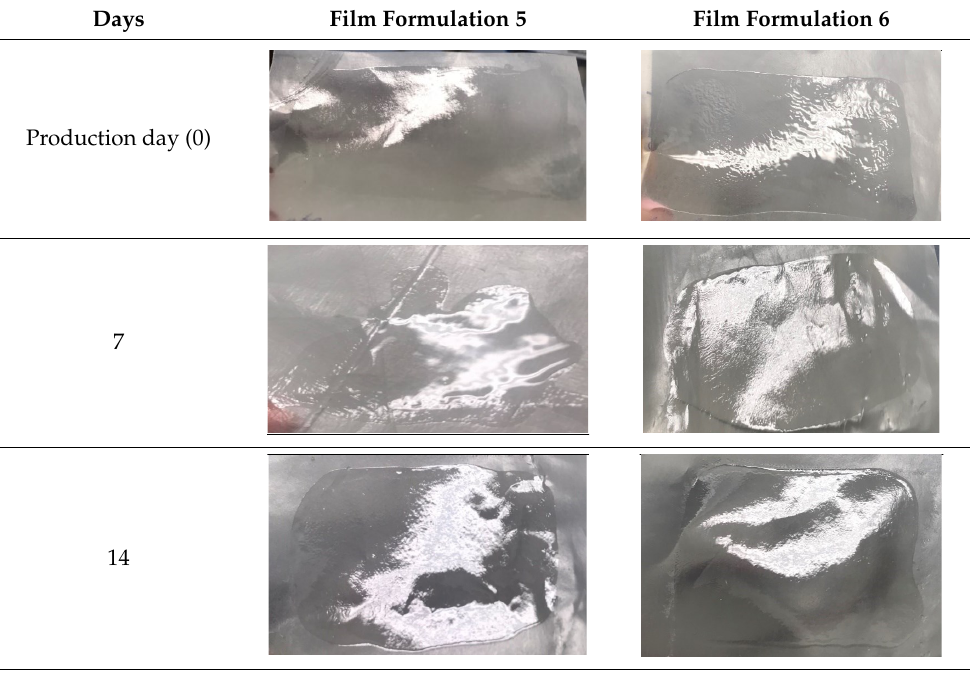
Table 5. Status of the control and non-control gels formulation before and after the stability study.